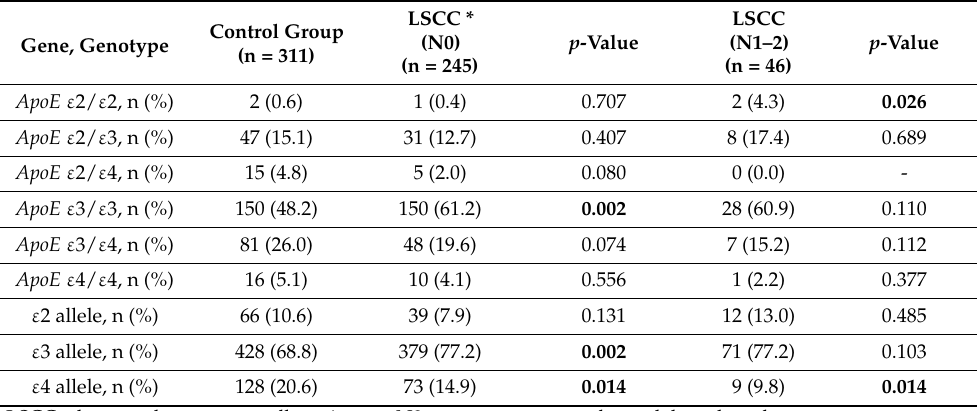
Table 8. Frequencies of ApoE genotypes and alleles in healthy controls and LSCC patients with (N1–2) and without (N0) metastases to the neck lymph